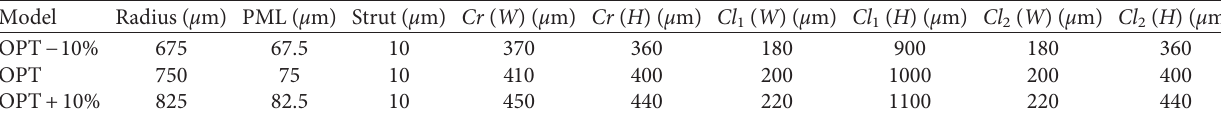
Table 1: Design parameters for three variations of the sensor